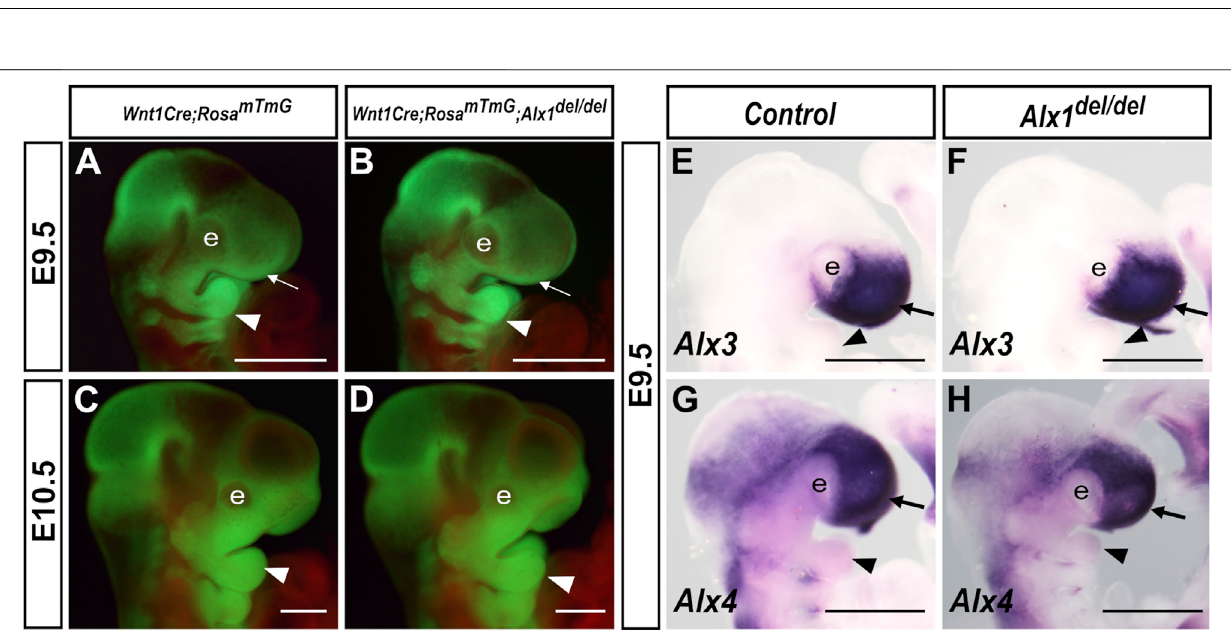
FIGURE 4 | Patterns of expression of Alx1 during frontonasal development. Whole mount lateral (A, C, E) and frontal (B, D, F) views of the Alx1 mRNA expression (blue/purple color) pattern in wildtype embryos at SS15 (A, B) , SS22 (C, D) and E10.5 (E, F) . Arrows in (A, C) point to the optic placode. Asterisk in (B, D) marks the position of the anterior neural ridge. (G, H) Representative frontal sections of E10.5 wildtype embryos showing immuno fl uorescent staining of ALX1 (red) and CDH1 (E-cadherin)(green)proteins,respectively,intheperiocular (G) andfrontonasal (H) tissues.DAPIcounterstainingisshowninblue.Scalebarsin (A – F) and (G,H) are 500 and 200 μ m, respectively. e, eye; lnp, lateral nasal process; mnp, medial nasal process; mxp, maxillary process; oc, optic cup; os, optic stalk; pom, periocular mesenchyme.